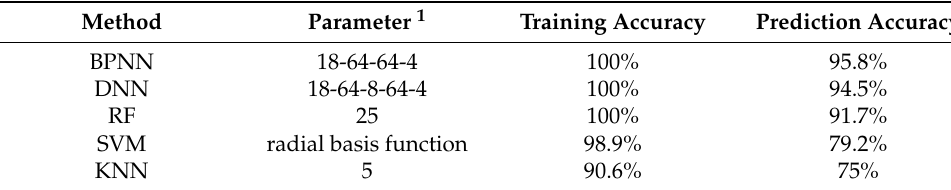
Table 2. Classification accuracy of BPNN and